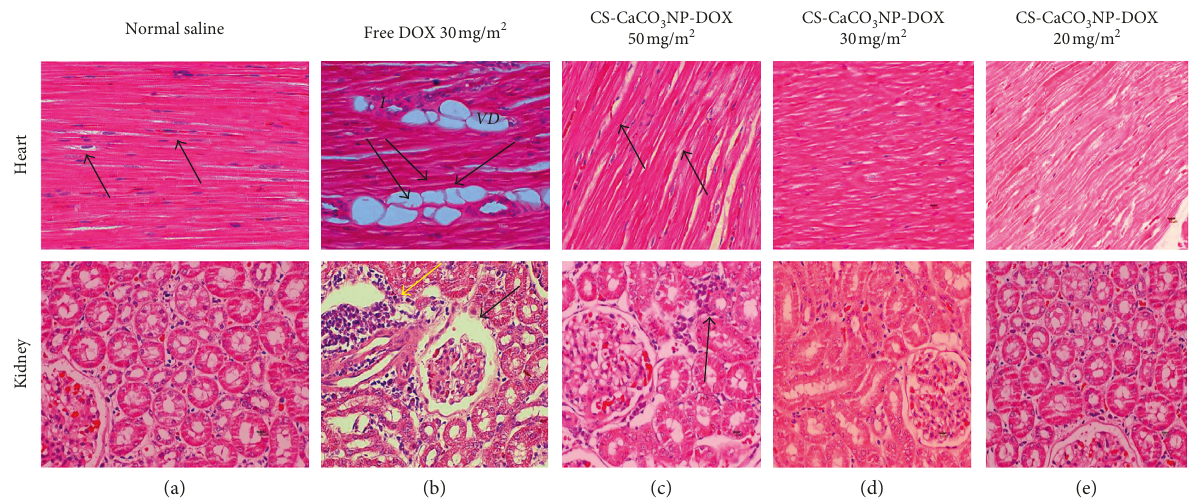
Figure 8: Photomicrograph of the longitudinal section of left ventricular myocardium and kidney section. (a) Ventricular myocardium and kidney section of the dogs given normal saline showing normal morphological architecture of the cardiomyocytes, myocardial fibres, and both glomerular (G) and renal tubular structure (PT). (b) Myocardium of the dogs given free DOX 150mg/m 2 showing myofibrillar loss, myocardial fibre disruption, multifocal cytoplasmic vacuolation (V), cardiomyocyte disorientation, cellular infiltration (I), and myocytolysis (M) with the kidney section showing dilated glomerular capsular space and dilation of the proximal renal tubular (DPT) with severe intercellular infiltration. (c) Myocardium of the dogs given CS-CaCO 3 NP-DOX 250mg/m 2 showing myofibrillar loss, vacuolation (v), cardiomyocyte disorientation, and cellular infiltration with the kidney section showing dilated renal tubules and focal areas of congestion. (d) Myocardium of the dogs given CS-CaCO 3 NP-DOX 150 mg/m 2 showing normal myofibril with spindle-shaped centrally placed cardiomyocytes with the kidney section revealing normal architecture glomerulus and renal tubules. (e) Myocardium and kidney section of the dogs given CS-CaCO 3 NP-DOX 100mg/m 2 showing normal myofibril structure and normal structural morphology of glomerulus and renal tubules (H & E) Scale bar 10 µ